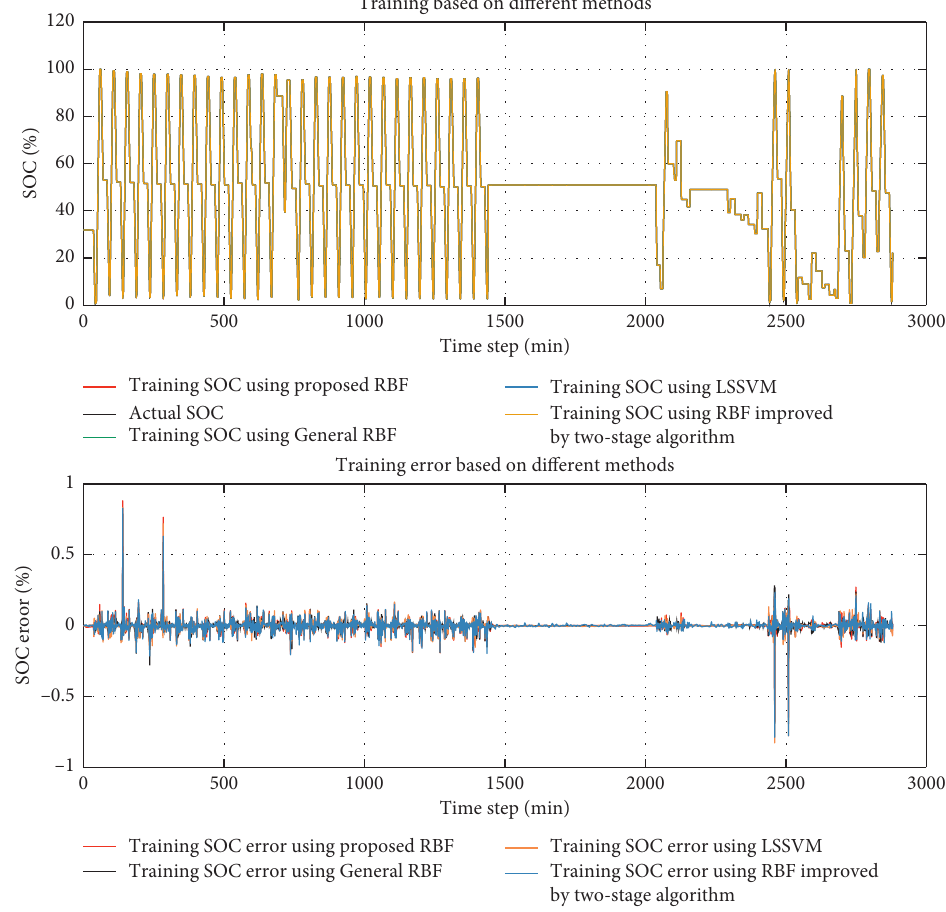
Figure 4: Training results of the FUDS process using different